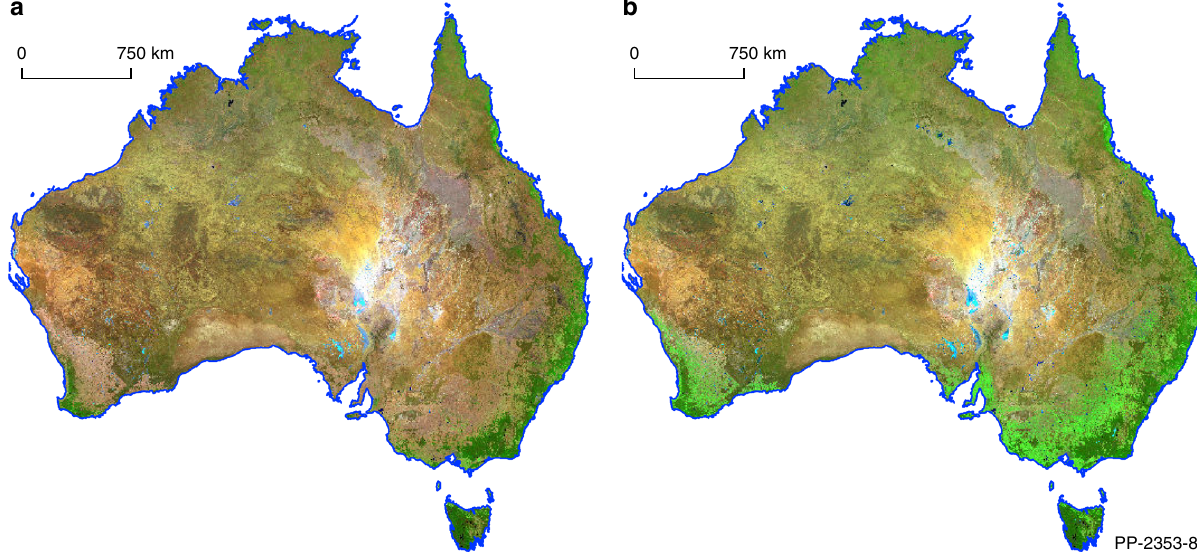
Fig. 1 Comparison of the Landsat-8 Barest Earth mosaic to its inverse, most vegetated state, to highlight the reduction in vegetation in fl uence. The mosaics are coloured using shortwave infrared 1.57 – 1.65 µ m, near infrared 0.85 – 0.88 µ m, green 0.53 – 0.59 µ m in the red, green and blue image channels. a Barest Earth Landsat-8 mosaic, b Most Vegetated Landsat-8 mosaic generated by inverting the Bare Earth algorithm to get the opposite response. Remaining green areas in the Barest Earth mosaic indicate areas of persistent